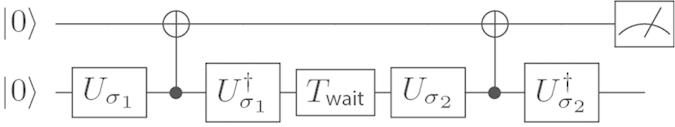
A quantum circuit for measuring correlations in time.